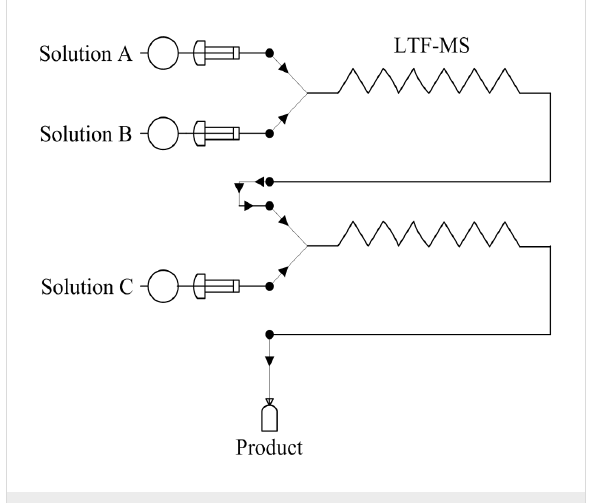
Figure 7: Schematic representation of the microreactor set